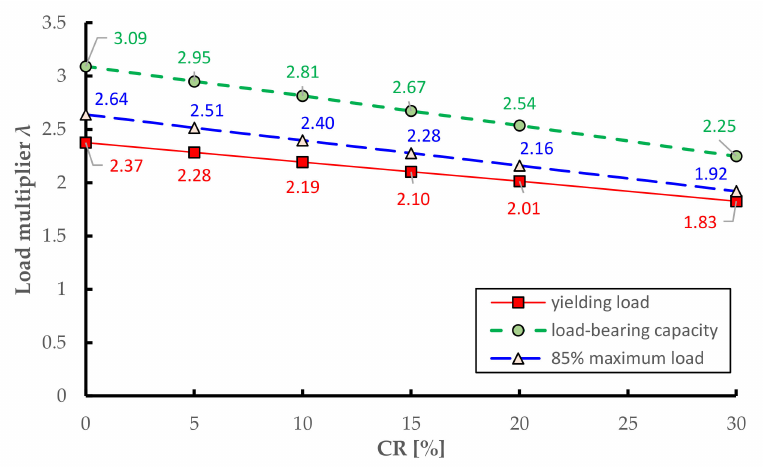
Figure 21. Reduction of load multipliers obtained from nonlinear static analysis of the bridge deck for increasing corrosion